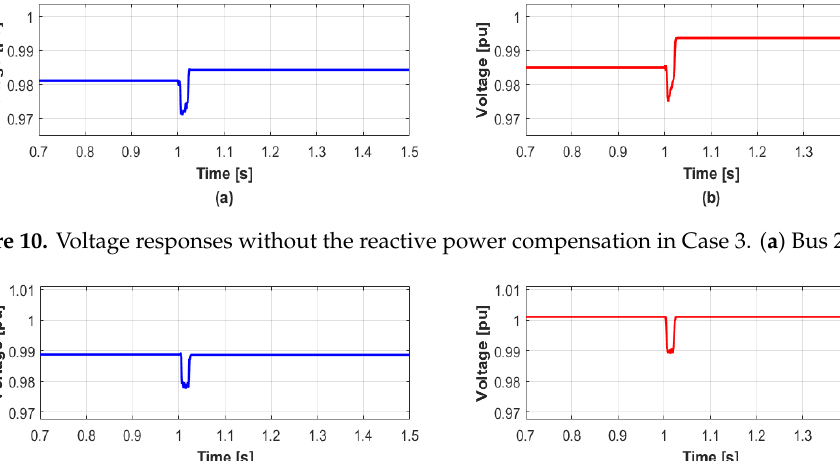
Energies 2019 , 12 , x FOR PEER REVIEW 12 of 19